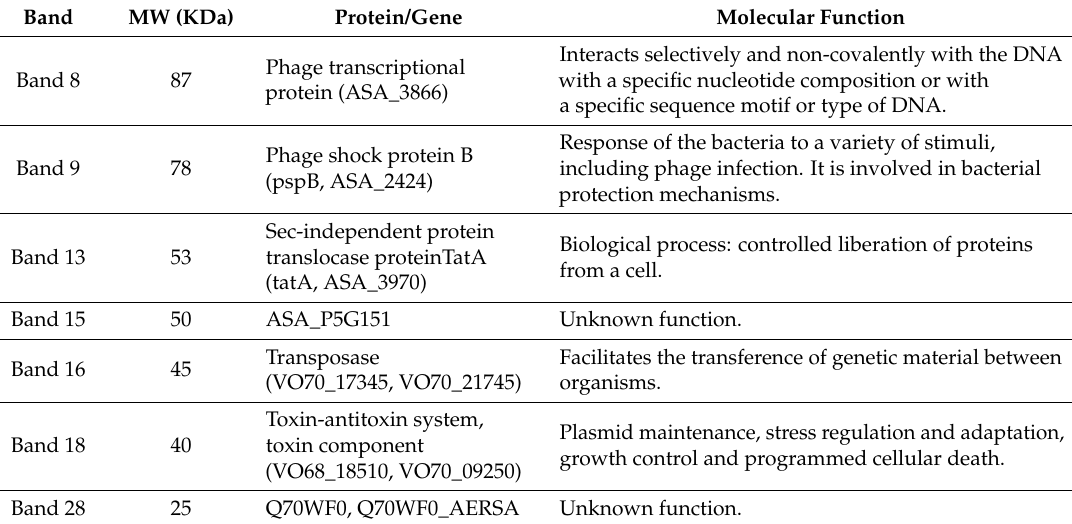
Table 2. Presumptive band identification of the 1-D electrophoresis gel of intracellular proteins, associated proteins and their molecular